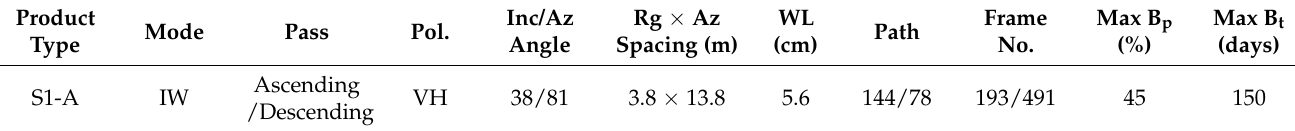
Figure 6. SAR interferograms showing spatial-temporal baseline distribution, where each acquisition is represented by a diamond associated with an ID number; the yellow diamond represents reference acquisition and green diamond represents the secondary time position plot of all interferograms gen- erated by S1 data showing a perpendicular baseline between different image’s acquisition according to their relative position. Table 1. Sentinel-1A data specification. The product type is L1 single look complex (SLC) with ascending and descending geometry and interferometric wide swath beam mode (IW). The following acronyms were used in the table: polarization (Pol), incident (Inc), azimuth (Az), range (Rg), wavelength (WL), maximum perpendicular baseline (Bp) and maximum temporal baseline